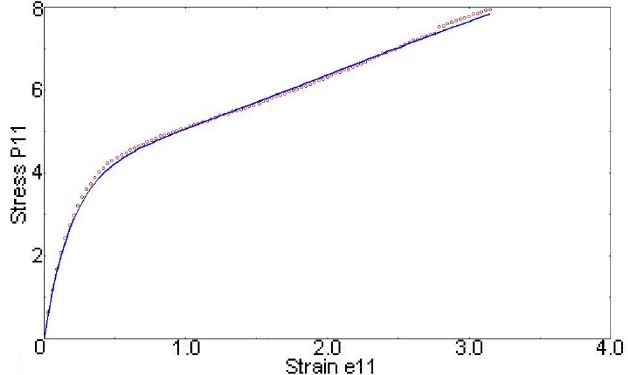
Figure 5. Ogden 3rd ‐ order material model fitted to average experimental data. Figure 5. Ogden 3rd-order material model fitted to average experimental data. Table 1. Ogden 3rd ‐ order fitted parameters. Table 1. Ogden 3rd-order fitted parameters.